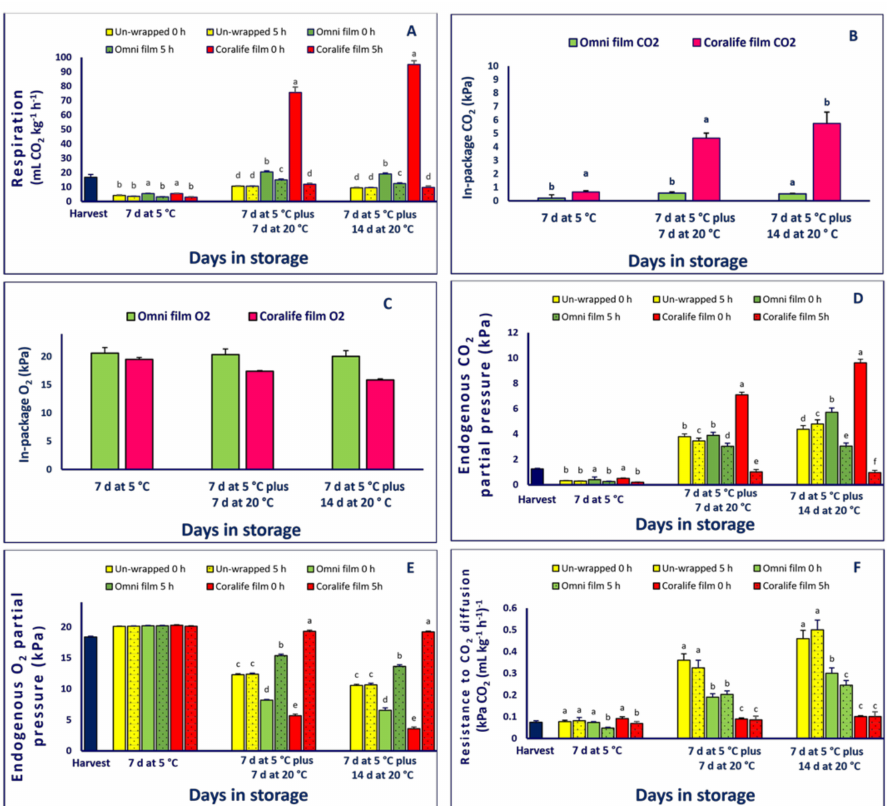
Figure 1. Respiration ( A ), in-package CO 2 ( B ) and O 2 ( C ), endogenous CO 2 ( D ), O 2 ( E ), and resistance to CO 2 diffusion( F ) of ‘Simeto’ mandarins. Vertical bars represent the standard deviation (n = 5 for respiration; n = 10 for in-package CO 2 and O 2 ; n = 5 for endogenous CO 2 , endogenous O 2, and resistance to CO 2 diffusion. For each storage time, means followed by unlike letters are significantly different at p ≤ 0.05. Means separation was accomplished by Duncan’s multiple range test.